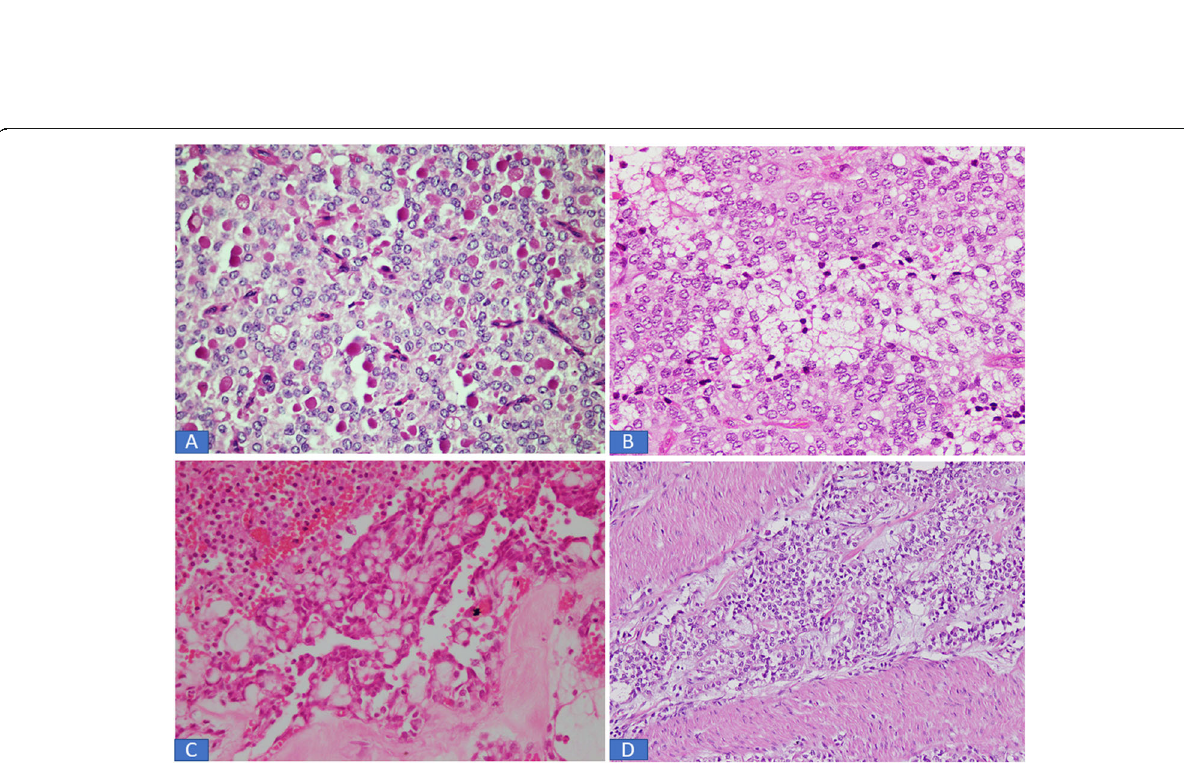
Fig. 3 a A number of eosinophilic hyaline globules are seen in the cytoplasm of tumor cells b Collections of foamy histiocytes are often seen. c Focal microcystic areas are not an infrequent feature. d A tumor in our series seen involving duodenal